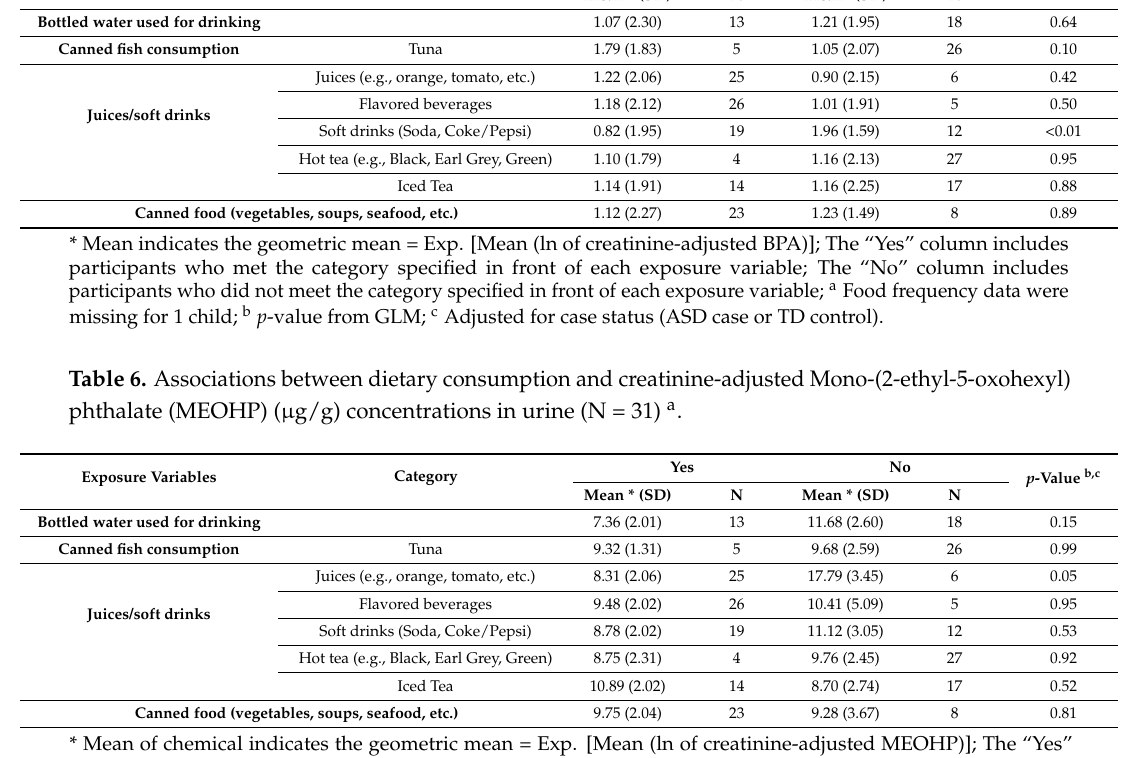
Table 5. Associations between dietary consumption and creatinine-adjusted dibenzofurans, bisphenol A (BPA) ( µ g/g) concentrations in urine (N = 31) a . Exposure Variables